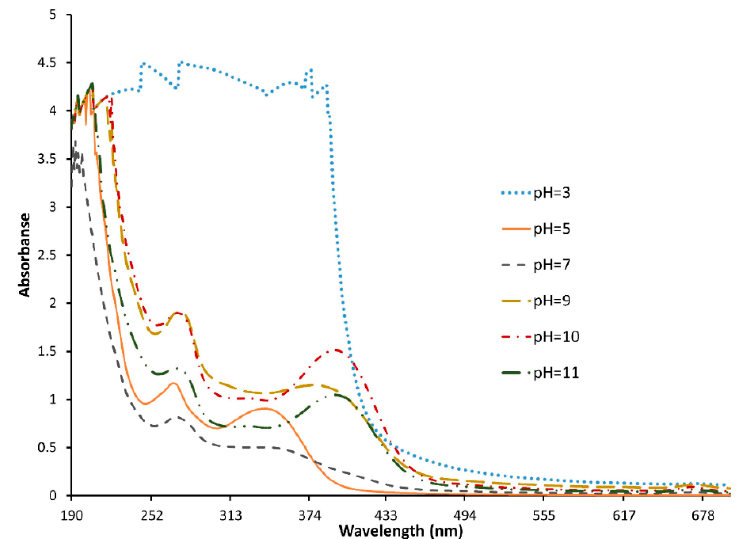
Figure 2. UV-Vis spectrophotometer of AgNPs prepared at different pH values, in the range of 3 to 11, synthesized from B. flexuosa leave extract, in the range of 190–700 nm, using ultraviolet-visible (UV-Vis) spectrophotometer (EMC-61PC-UV, Duisburg, Germany).